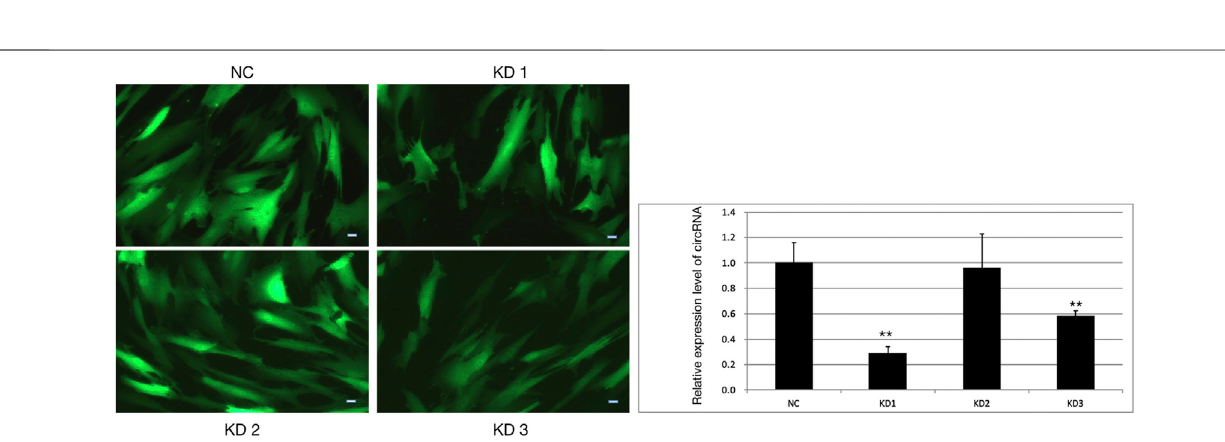
Frontiers in Molecular Biosciences |